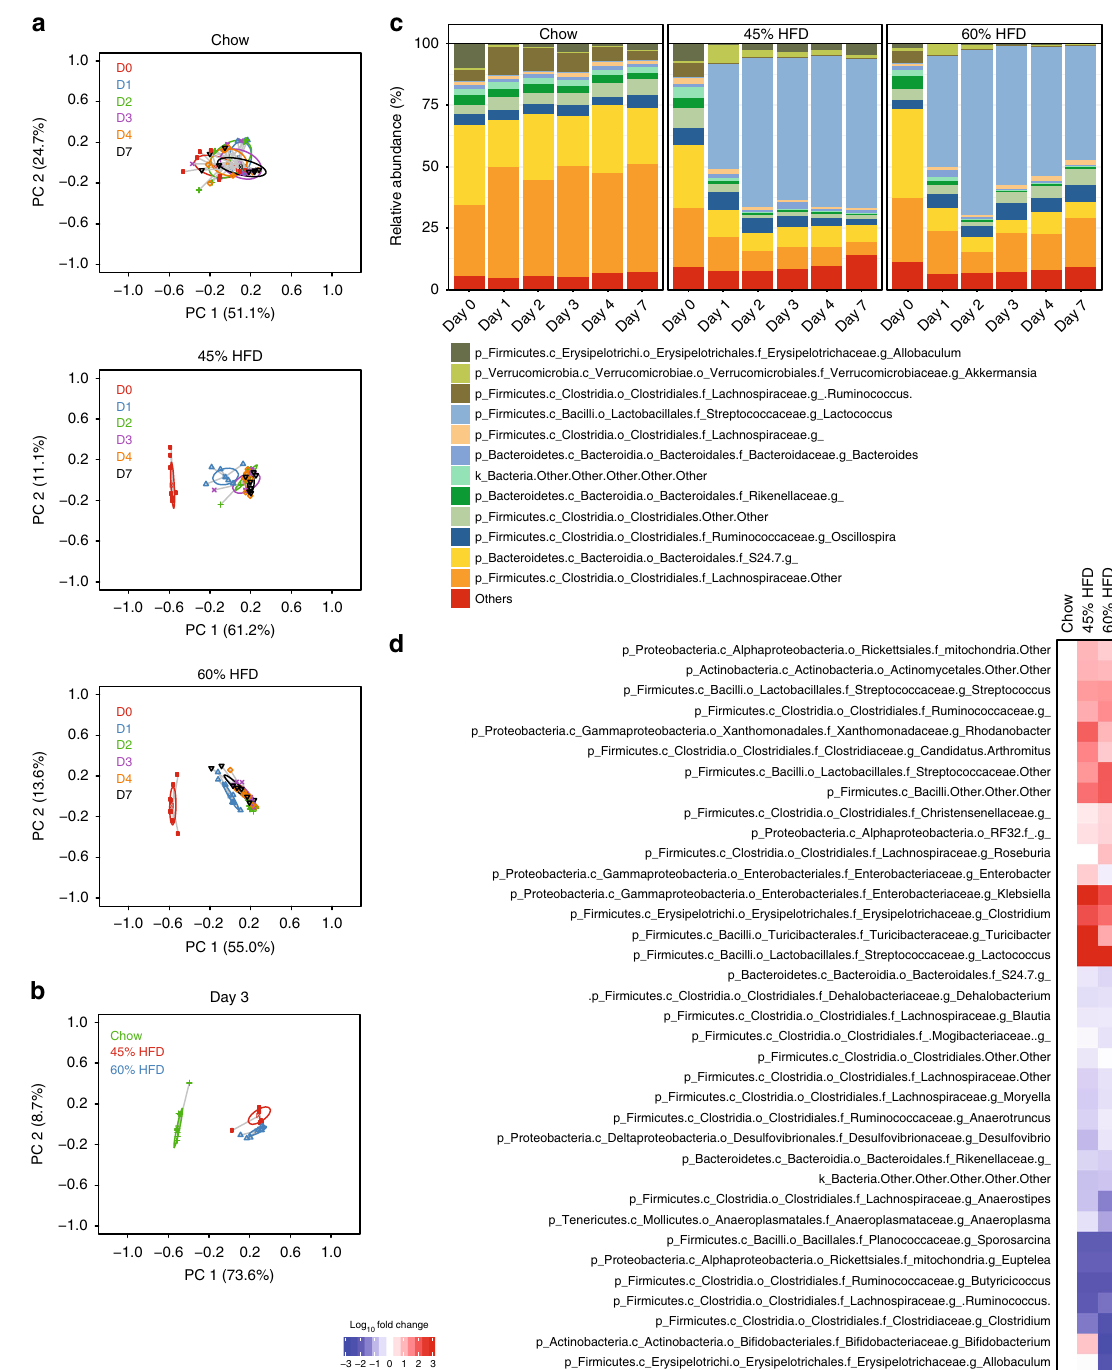
Fig. 2 Obesogenic diet feeding changes the fecal microbiota, which precedes glucose intolerance in mice. Mouse fecal samples were taken over the fi rst 7 days (D0 – D7) of feeding obesogenic, low fi ber, high fat diets (HFD) and processed for bacterial DNA sequencing ( N = 7 – 8). All mice were on a Chow diet on Day 0 (D0). a PCoA of Bray-Curtis dissimilarity for all samples over the 7 days on Chow diet, 45% HFD, or 60% HFD. b PCoA of Bray-Curtis dissimilarity after 3 days of eating each of the 3 diets. c Stacked bar graph showing the relative abundance of the 12 most abundant bacterial taxa (Genus level) over the fi rst 7 days of eating each of the 3 diets. d Heat map of the 36 microbial taxa that were signi fi cantly different 3 days after eating Chow, 45% HFD, and 60% HFD. Non-parametric analysis of variance for each taxon between groups was conducted using the Kruskal – Wallis test. Taxa that passed the signi fi cance threshold of p < 0.05 were analyzed using the pairwise Wilcoxon rank sum test. Correction for multiple hypothesis testing (FDR) was calculated using the Benjamini-Hochberg method. Statistical signi fi cance was accepted at p < 0.05. Fold change in relative abundance of the taxa that signi fi cantly changed between the groups was expressed relative to Chow and plotted in the